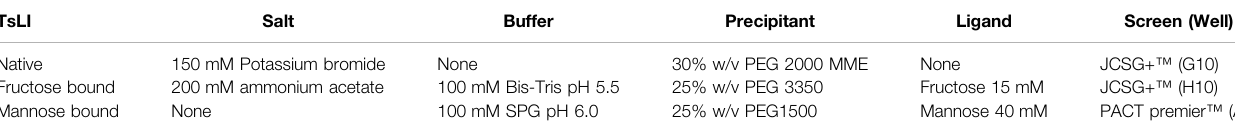
TABLE 3 | Crystallization condition of the different TsLI structures characterized in this study. TsLI Salt Buffer